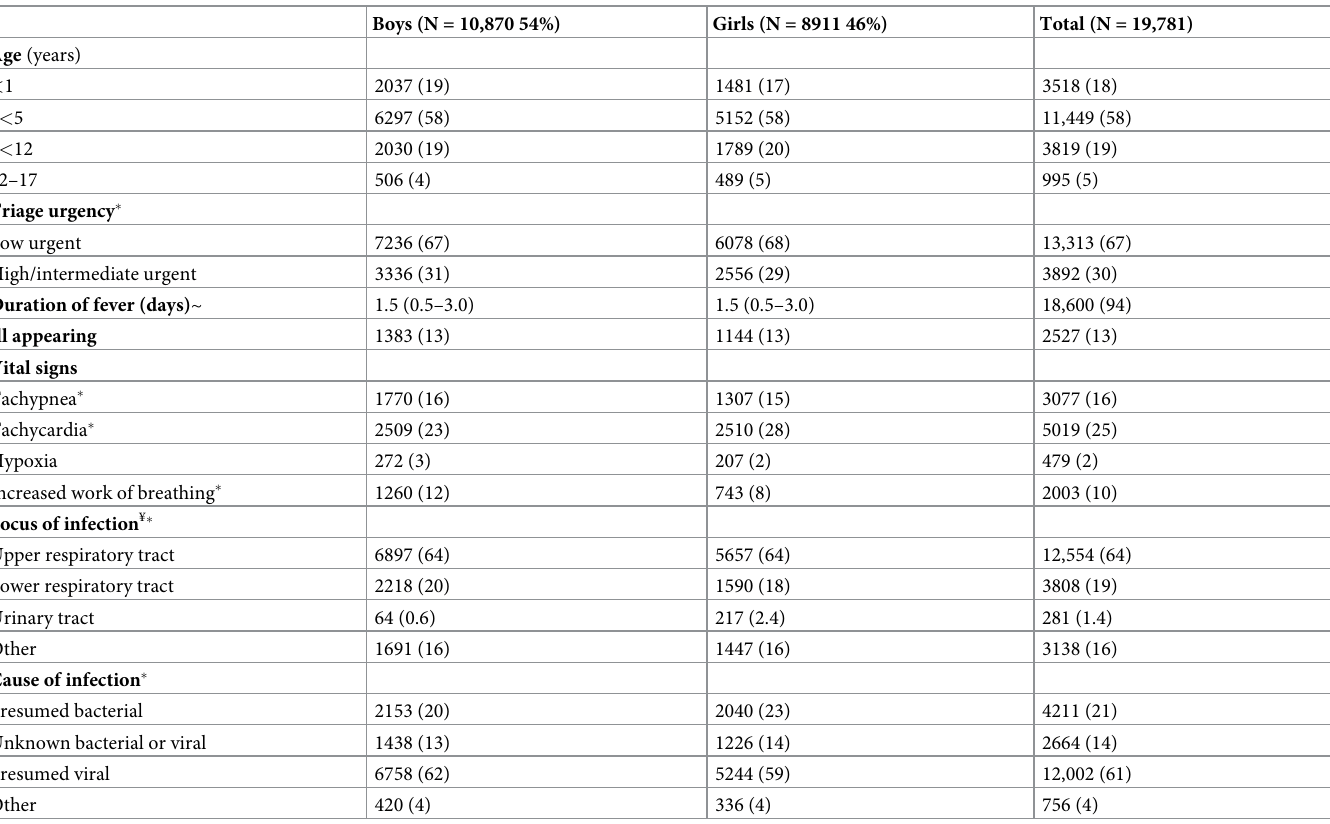
Table 1. Patient characteristics stratified by sex (N =